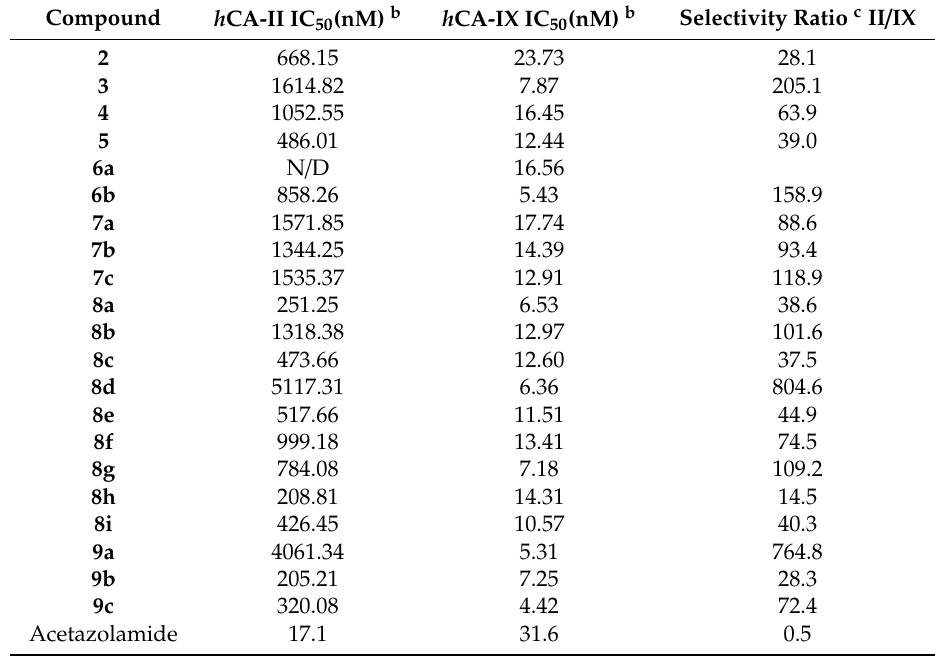
Table 1. In-vitro a data of the human carbonic anhydrase inhibition assay for the bumetanide compounds.